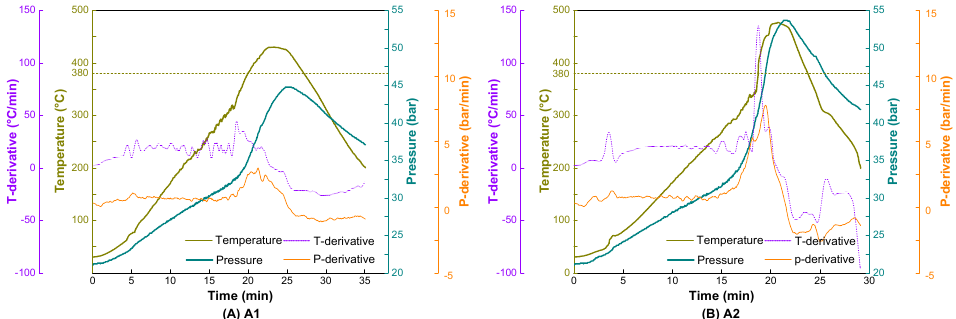
Figure 3. Temperature and pressure vs. time curves of experimental processes in different high- pressure atmospheres (helium, argon and nitrogen).